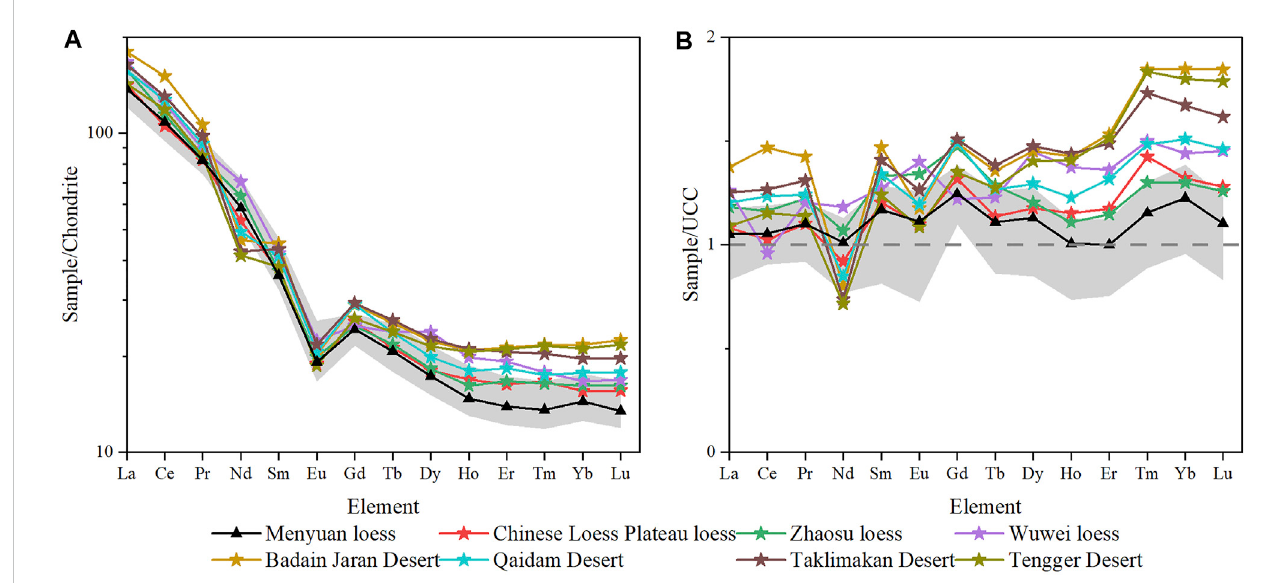
Chondrite-normalized (A) and UCC-normalized (B) distribution patterns of rare earth elements patterns for the regions of this study. The grey areas are the ranges of Menyuan loess.